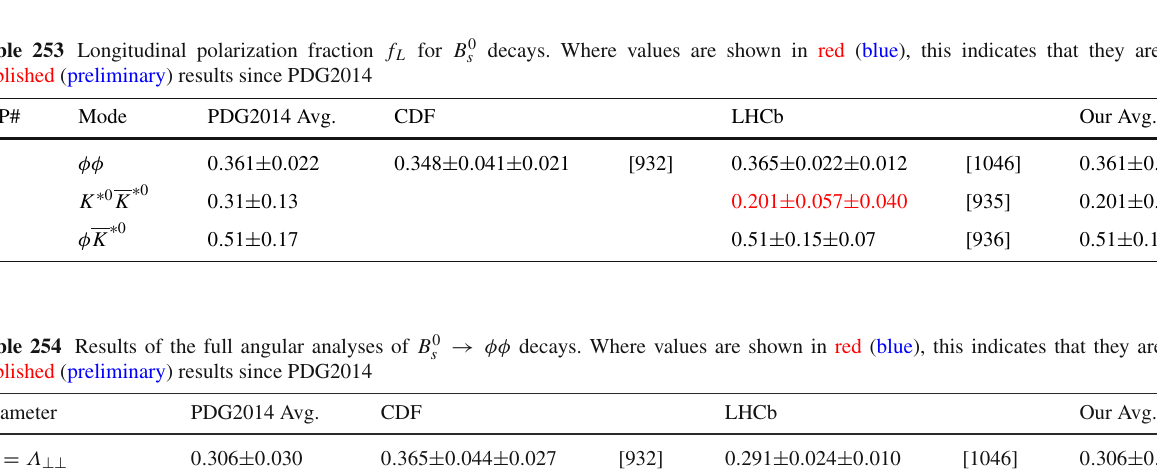
Table 252 Results of the full angular analyses of B 0 → φ K ∗ 0 are new published (preliminary) results since PDG2014 Parameter PDG2014 Avg.